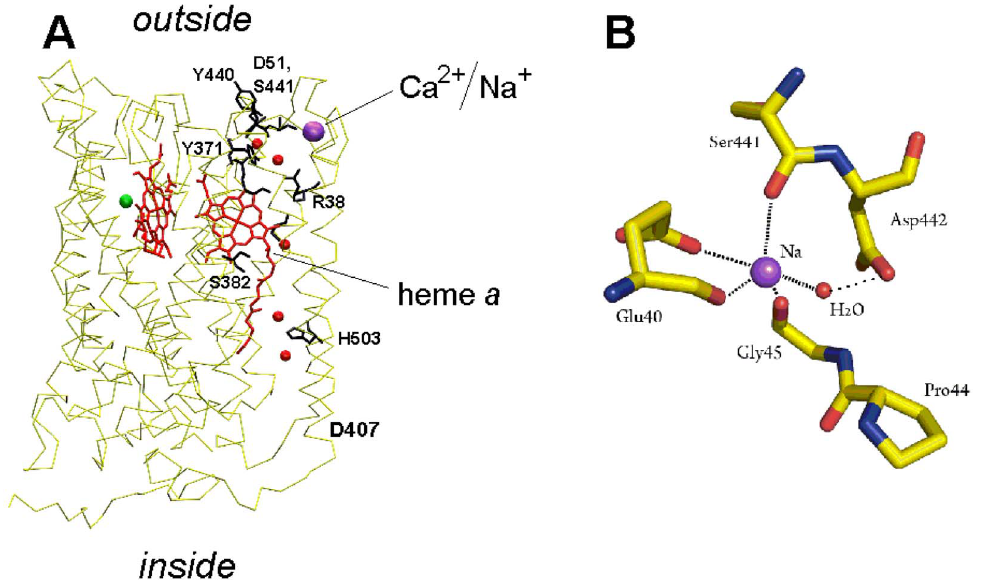
Figure 1. The Cation Binding Site in cytochrome c oxidase. ( A ) Location of the Cation Binding Site in subunit I of bovine enzyme and its relation to the proposed proton conducting pathway H. Components of the H-pathway are depicted as orange spheres (fixed water molecules) and black sticks (amino acid residues, A-propionate and carbonyl groups of heme a ). Enlarged picture of the exit part of the H-channel is shown in Figure 8. ( B ) Coordination sphere of the bound cation in bovine oxidase. Based on the PDB 1V55